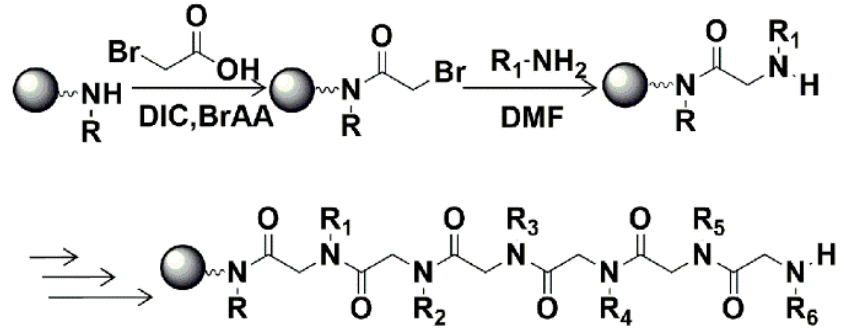
Figure 1. Schematic diagram of peptoid solid-phase submonomer synthesis method.